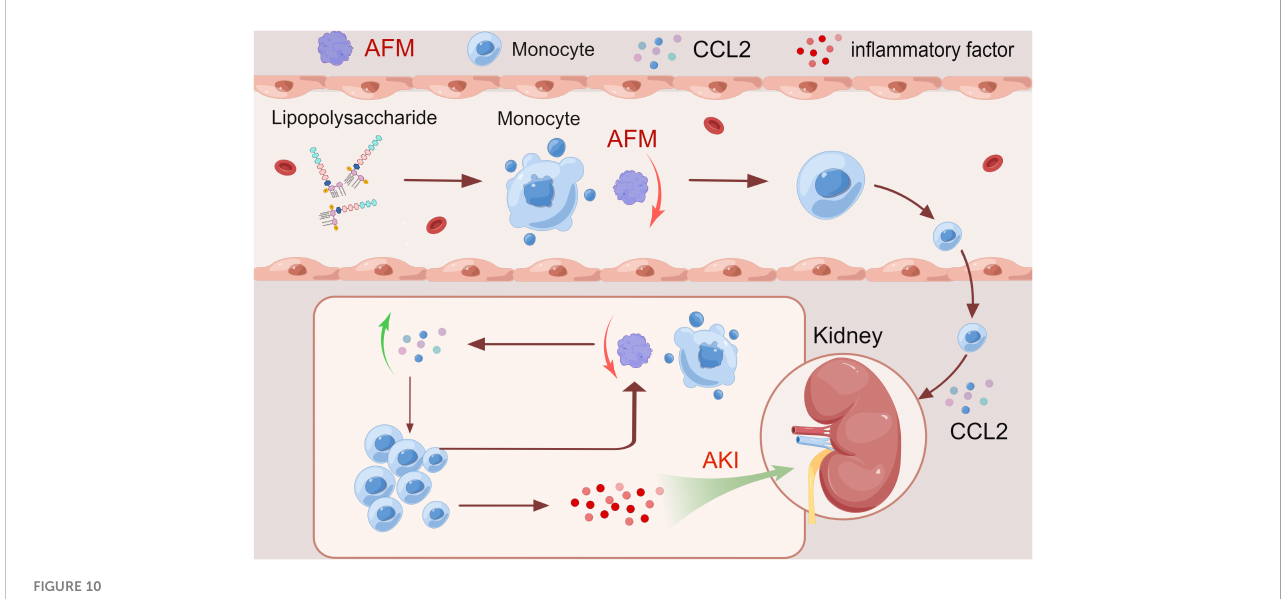
FIGURE 10 Hypothesis map was drawn by